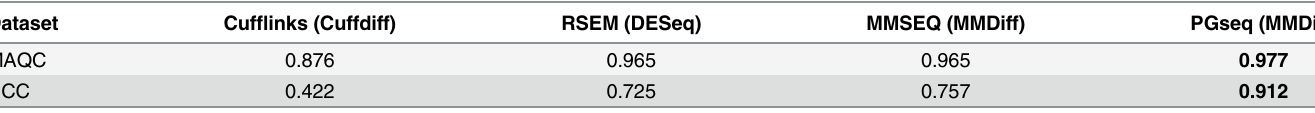
Cuf fl inks, RSEM and MMSEQ are combined with the corresponding embedded DE analysis methods, Cuffdiff, DESeq and MMDiff, respectively. PGseq is combined with MMDiff for propagating measurement error in the DE